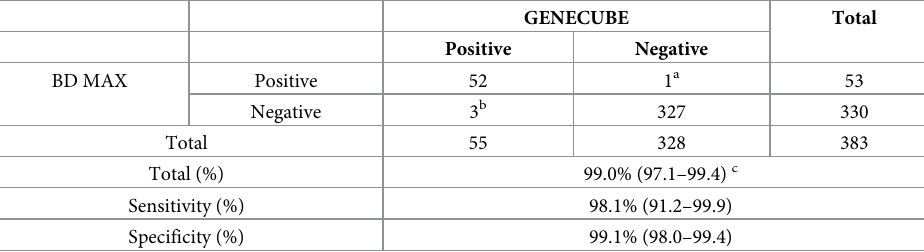
Table 3. Comparison of the GENECUBE Clostridioides difficile assay with BD MAX Cdiff